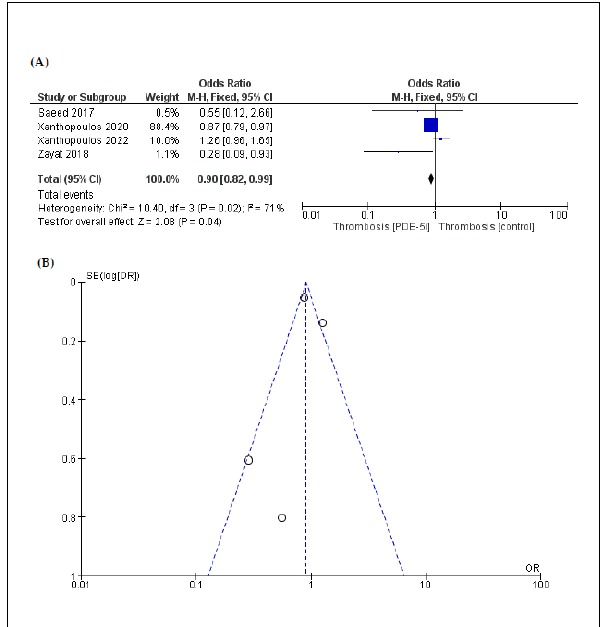
Figure 4. ( A ) Forest plot describing the differences in pump thrombosis between the 2 groups (PDE-5i vs. control); ( B ) funnel plot assessing the publication bias for pump thrombosis .